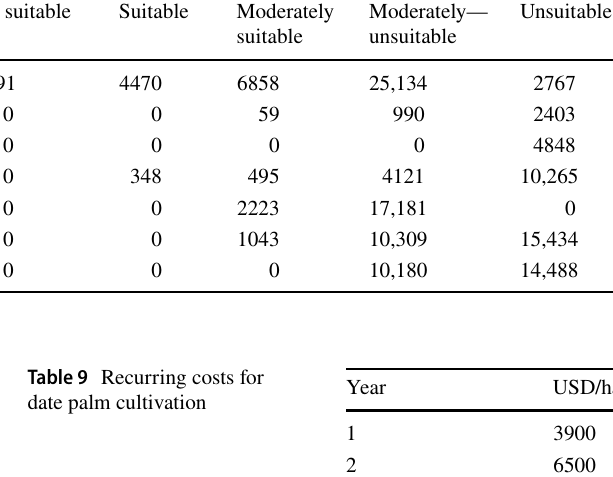
Table 7 Land availability for date palm cultivation in ha by district in the JRB part of the West Bank